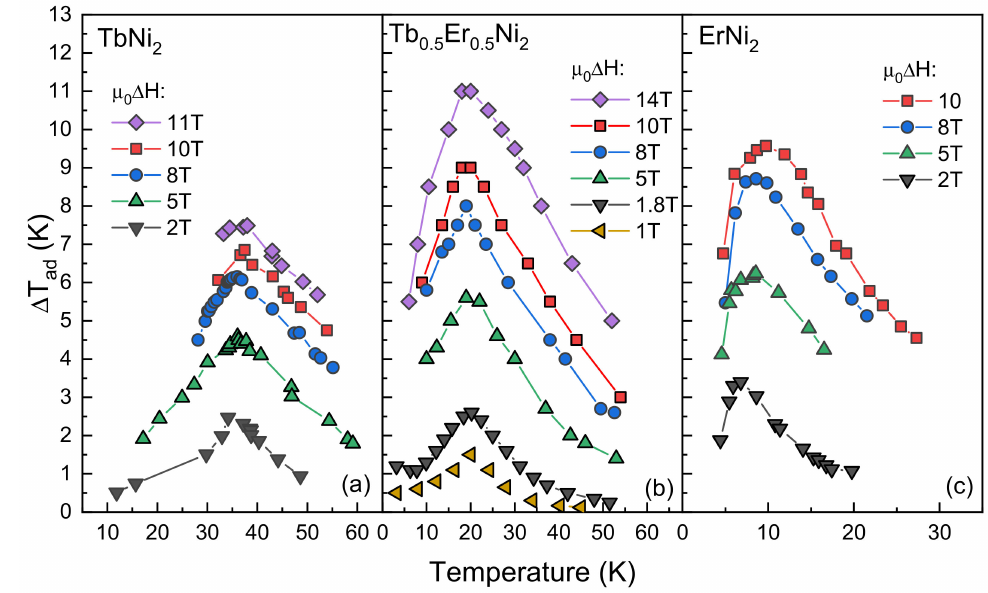
Figure 5. Temperature dependences of the adiabatic temperature change, ∆ T ad , obtained by direct measurements for TbNi 2 ( a ); Tb 0.5 Er 0.5 Ni 2 ( b ); and ErNi 2 ( c ); at different magnetic field changes ∆ H . The results for the binary TbNi µ 2 ( a ) and ErNi 2 ( c ) compounds taken from Refs. [11,12] are 0 shown for